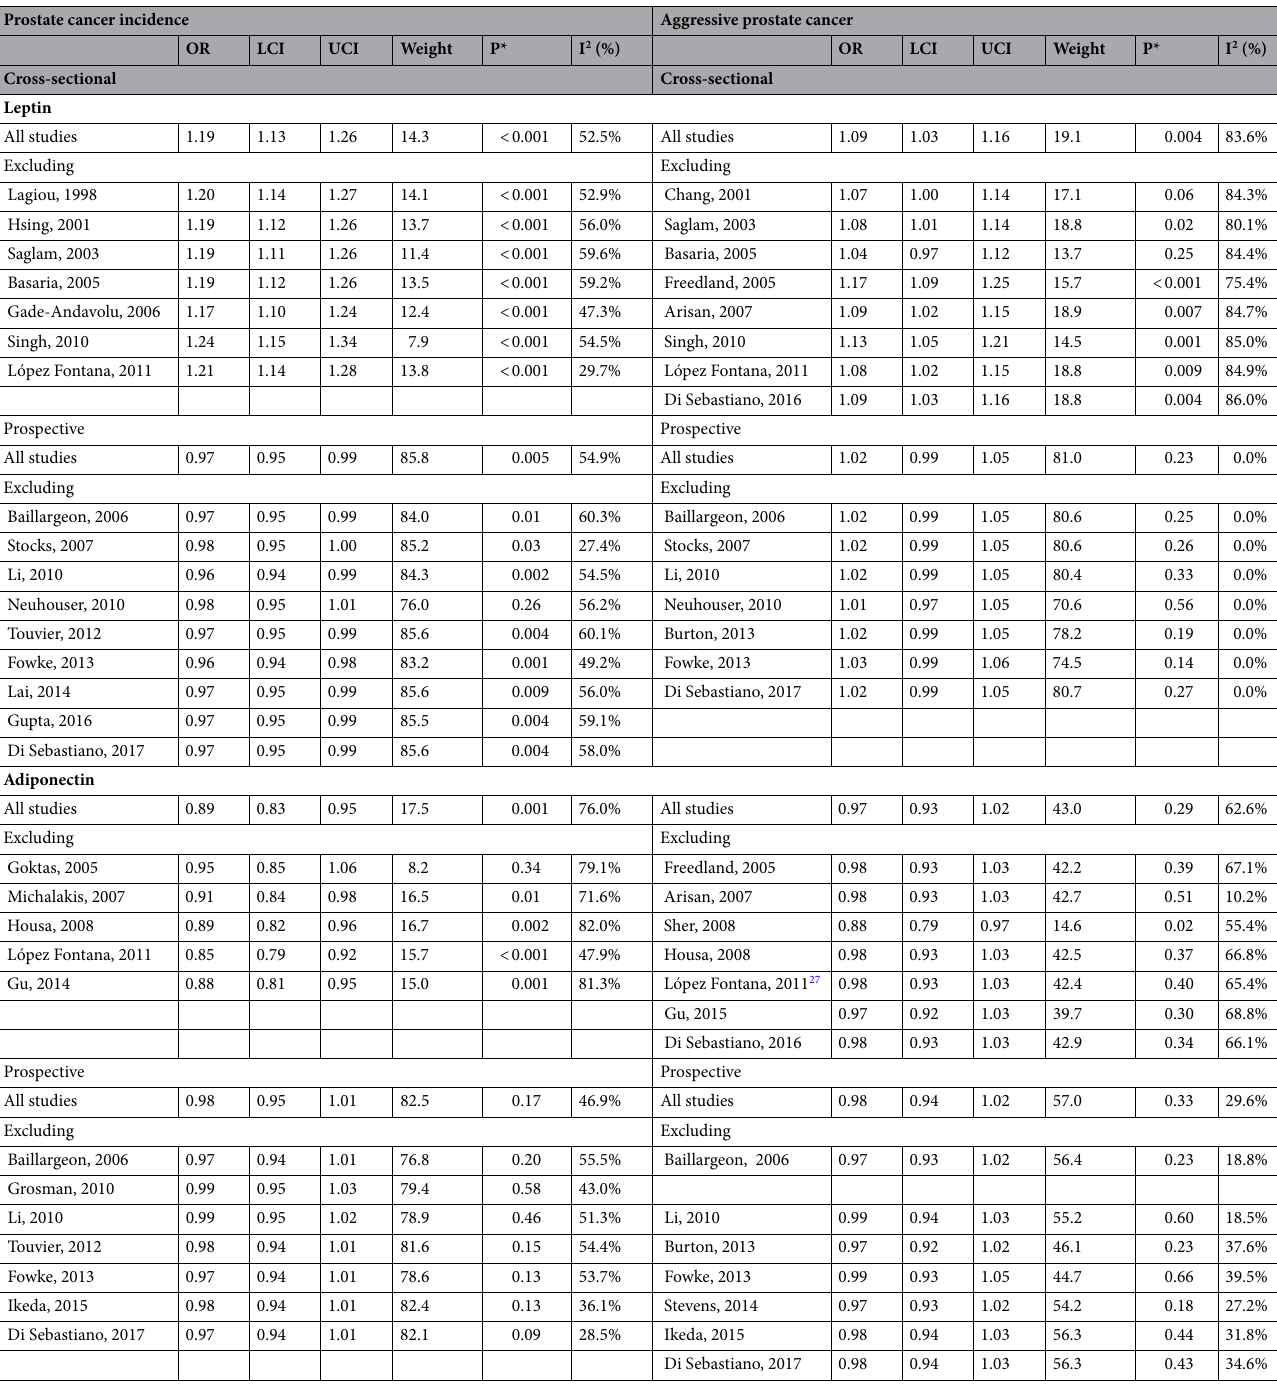
Table 2. Influence analysis. Studies were sequentially excluded and analyses repeated. Pooled fixed-effects odds ratios. ORs per 2.5 ng/ml increase in leptin or 2.5 μg/ml increase in adiponectin. OR odds ratio; LCI lower confidence interval; UCI upper confidence interval; NA not